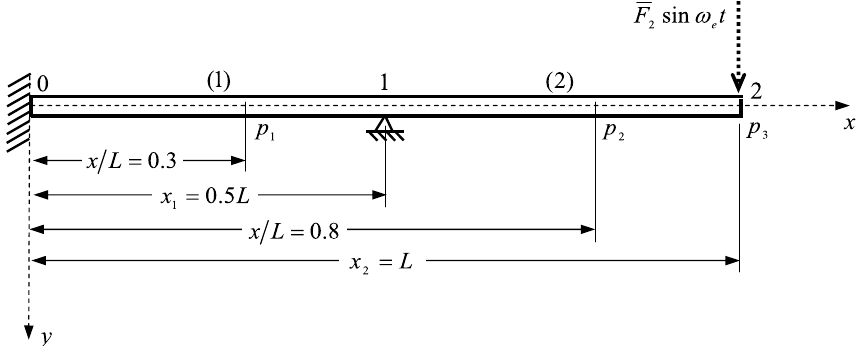
Fig. 4. A cantilever beam with an intermediate pinned support at mid-length (node 1) and subjected to a harmonic concentrated force ¯ F 2 sin ω e t at free end (node 2). simple approach is presented to determine the total response amplitude of a vibrating system by using NAM [22] and the relationship | Y ( x ) | t = [1 + ( ω e / ω )] · | Y ( x ) | s . The last relationship is derived from a single-degree-of- freedom (SDOF) system and can also be extended to the multi-degree-of-freedom (MDOF) system, since, near resonance (with ω e / ω ≈ 1 . 0) , the entire MDOF system will vibrate synchronously in a certain mode (looking like a SDOF system) and can be modeled by a SDOF system as one may see from reference [23] and the numerical examples presented in this paper. The frequency-response amplitude curves denoted by the solid lines ( −− ) shown in Figs 5, 7–10 of this paper are obtained from the above-mentioned